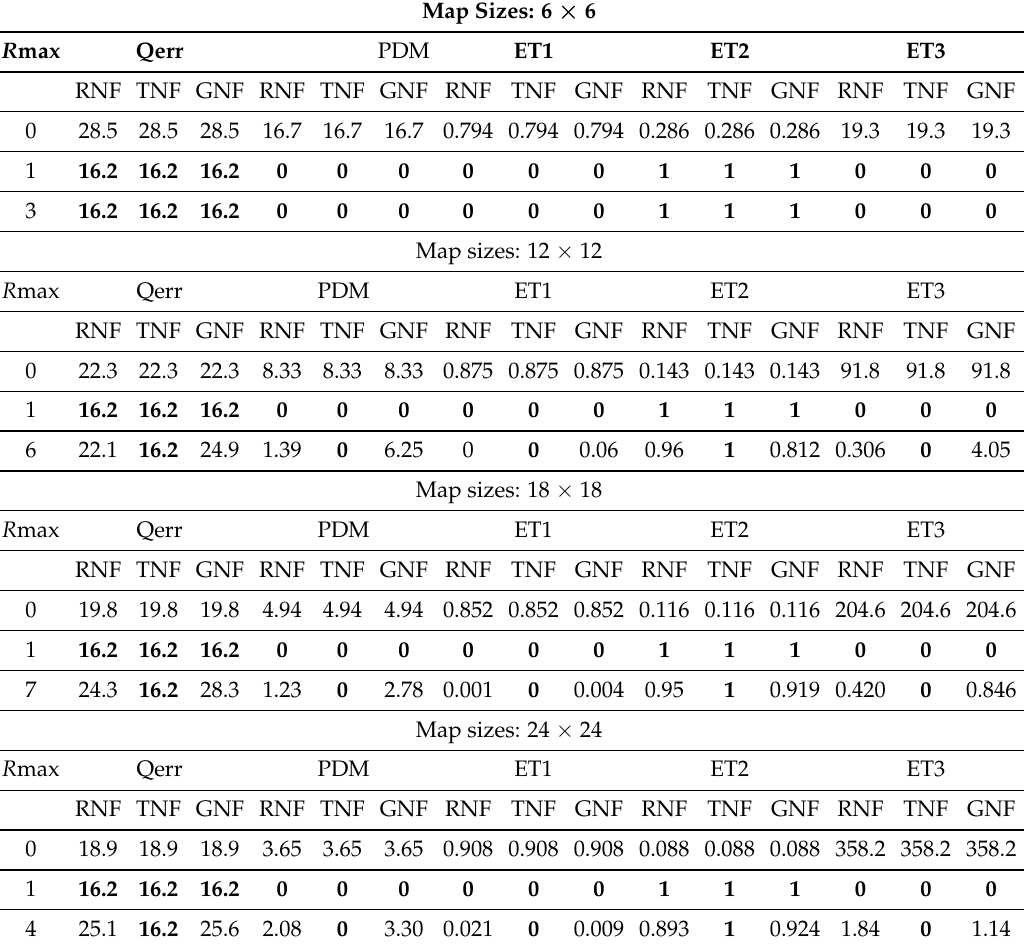
Table 1. The quality of the learning process treated as a function of the initial neighborhood range R max , for the RNF, GNF and TNF (selected